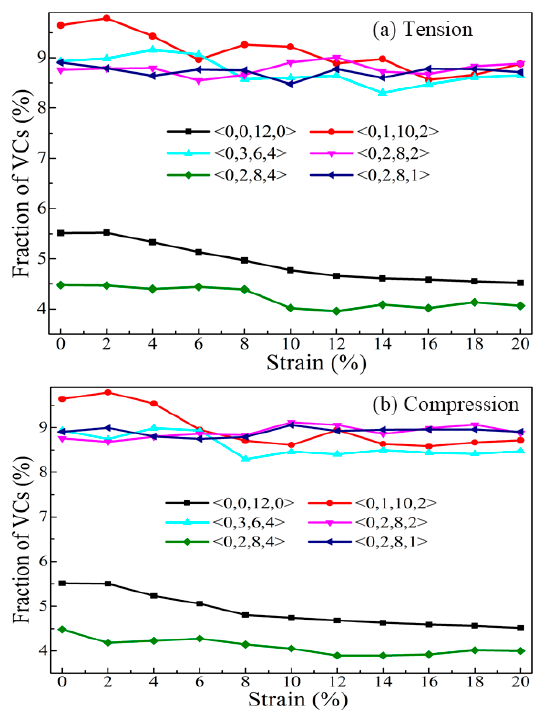
Figure 3. (Color online) Distribution of major Voronoi clusters during ( a ) tension and ( b ) compression.